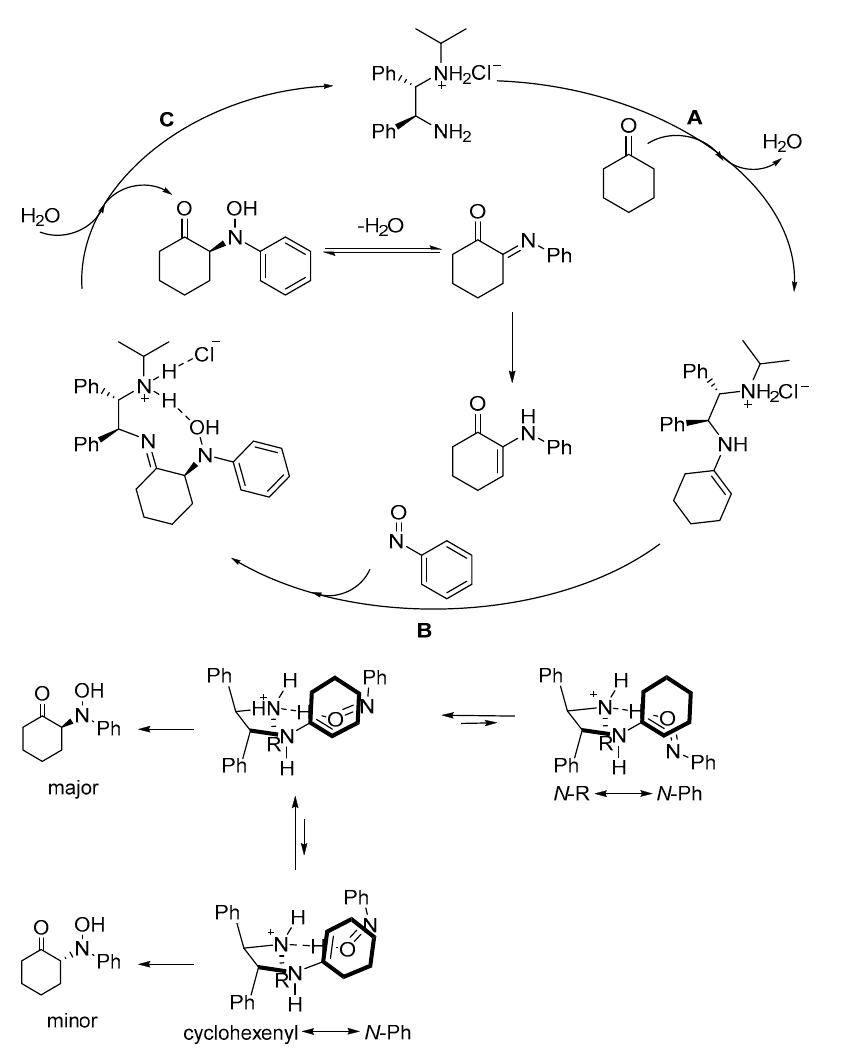
Figure 3. Catalytic cycle of the nitroso aldol reaction and proposed transition states.